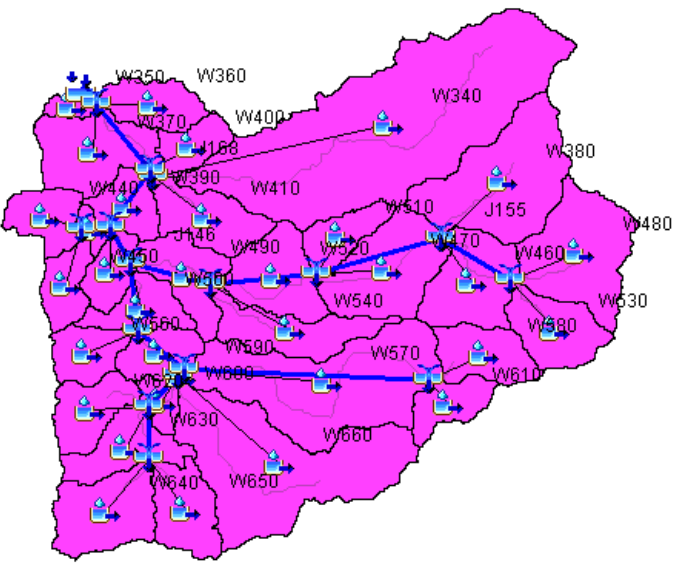
Figure 4. Extracted Basin Model of Odiongan, Romblon using GeoHMS10.7 tool in ArcpMAp. The results from the basin model for 25-, 50-, and 100-year (Figure 5) simulation were exported to excel for the data preparation for hydraulic modeling in HEC-RAS and Appl. Sci. 2022 , 12 , x FOR PEER REVIEW recorded 2.9 m 3 /s as its total highest inflow.